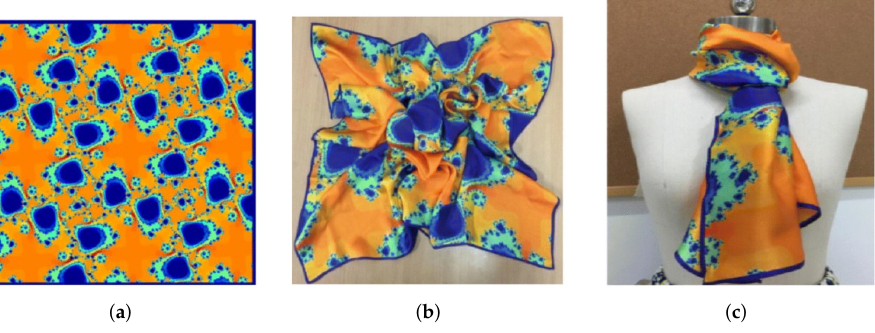
Figure 28. Silk scarves patterns and design (Wang et al. [56]). ( a ) Scarf design, ( b ) physical map, and ( c ) wearing